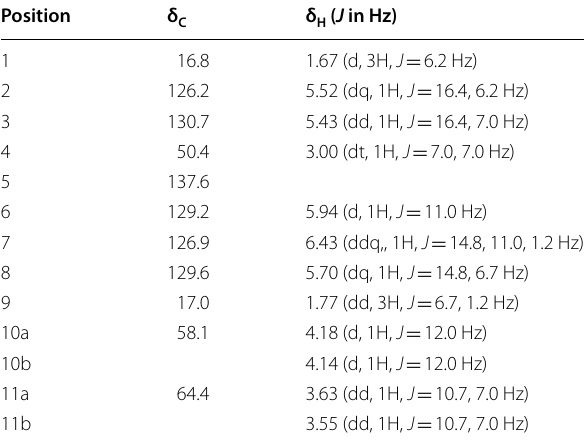
Table 2 NMR data of compound 1 in CD